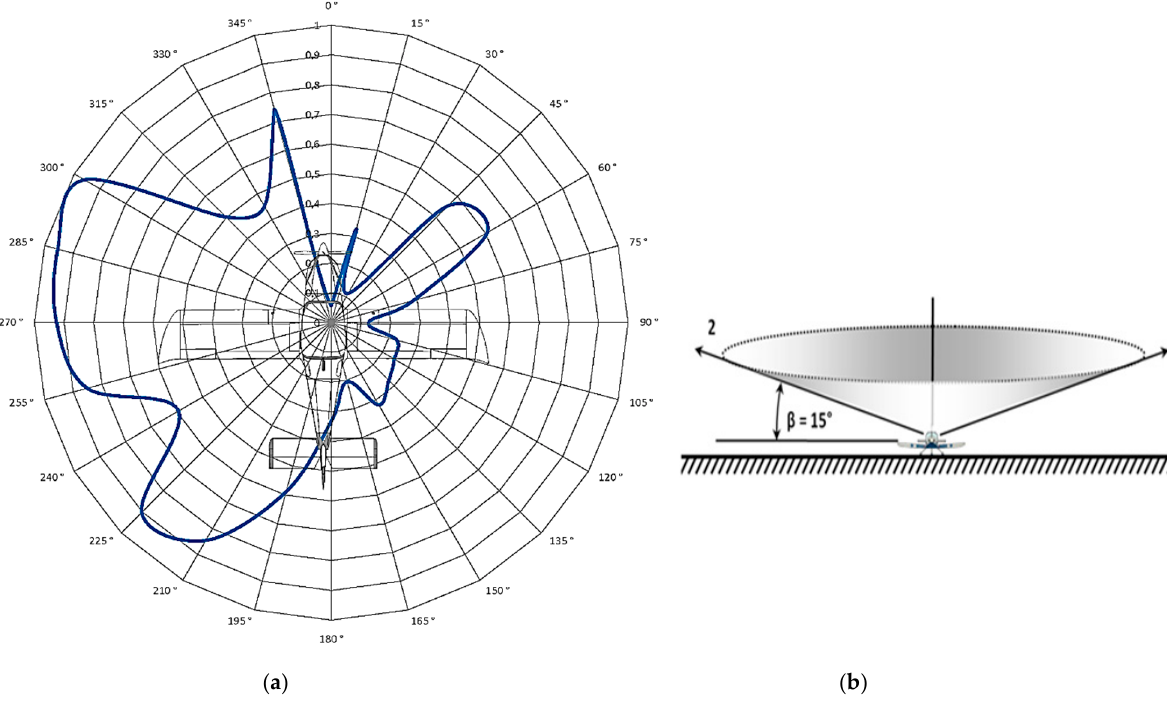
Figure 12. Measurement of the aircraft antenna characteristic at a position angle θ of 15°: ( a ) polar characteristics of the antenna; ( b ) spatial illustration of the measurement.